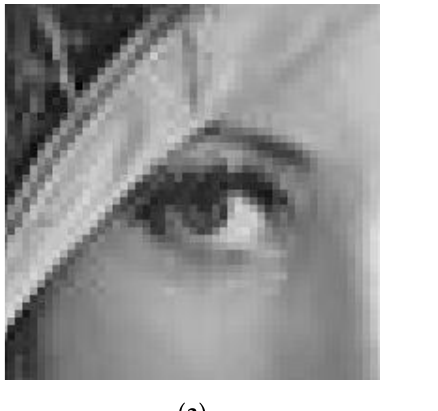
Figure 3. The zoomed images by factor 2 based on four different interpolant methods. ( a ) The zoomed images by factor 2 based on the nearest-neighbor interpolation method, ( b ) the zoomed images by factor 2 based on the bilinear interpolation, ( c ) the zoomed images by factor 2 based on the bicubic interpolation, ( d ) the zoomed images by factor 2 based on the proposed method.